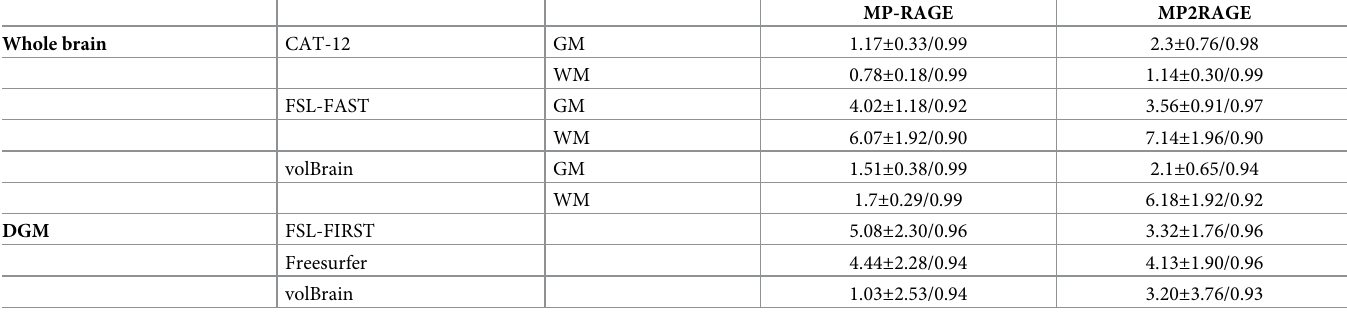
Table 4. Test-re-test of the mean percentage of overtime change and Cronbach’s α in whole-brain GM and WM, as well as deep grey matter (DGM) volumes assessed using the different automatic tools based on MP-RAGE and MP2RAGE.